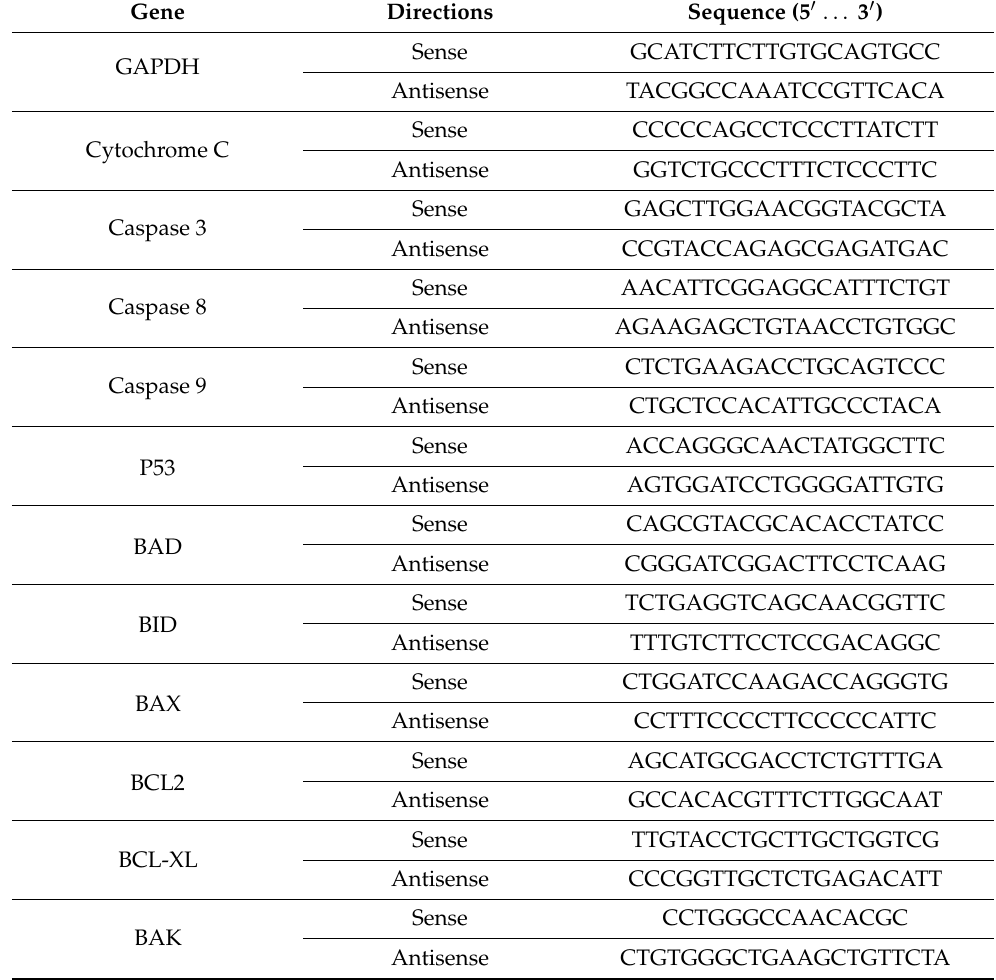
Table 1. List of primers used in this study.